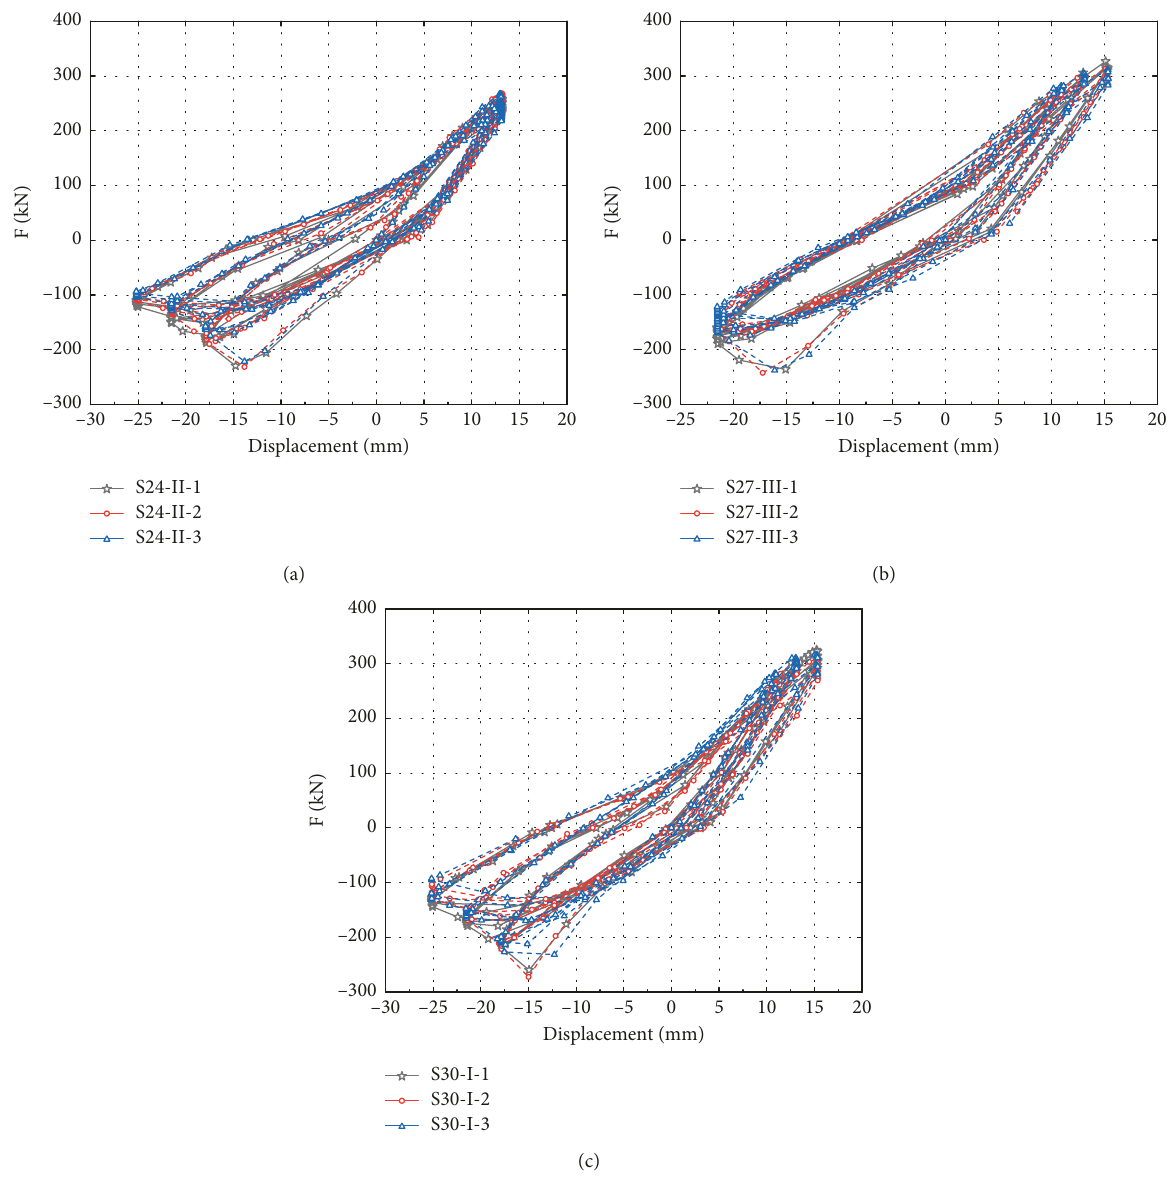
Figure 11: Hysteretic curve comparison. (a) S24-II. (b) S27-II. (c) S30-I.